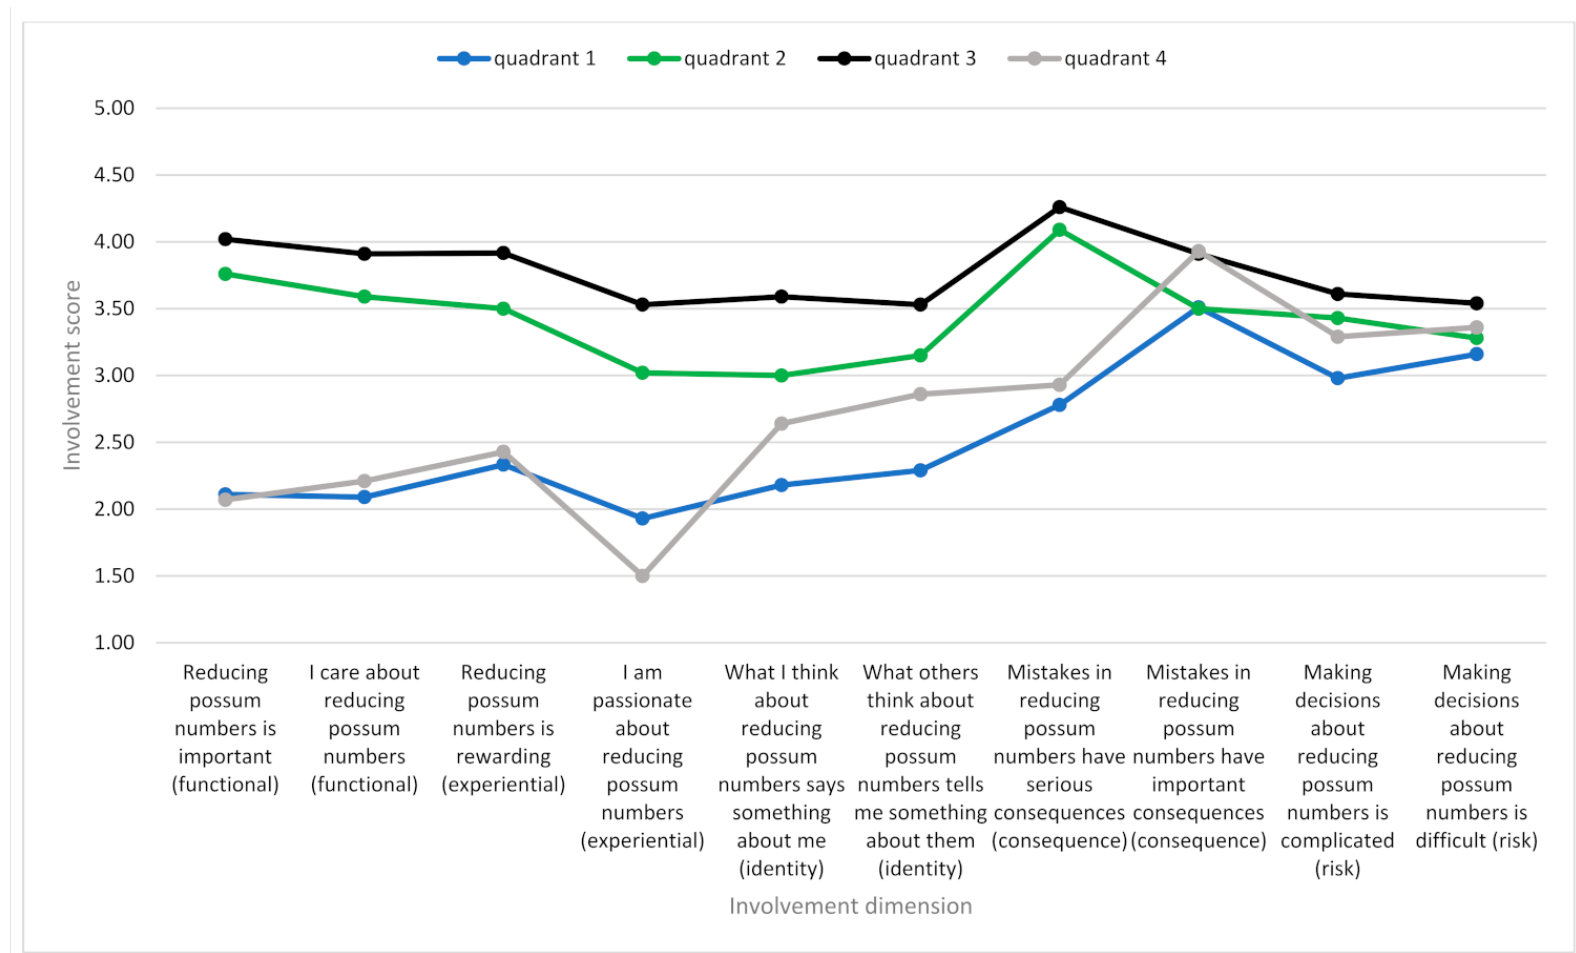
Figure 3. Involvement profiles for the idea of reducing possum